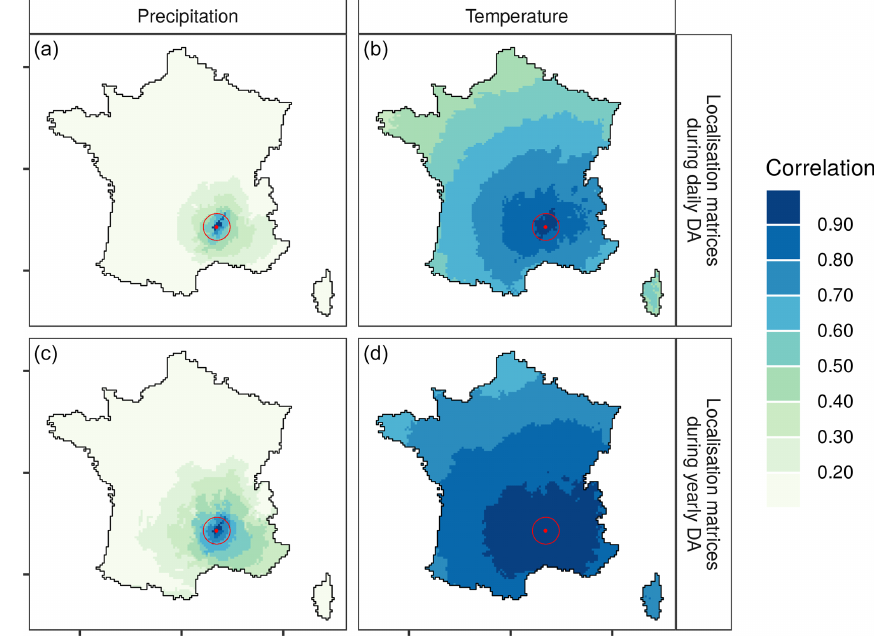
Figure 2. Correlation matrices between values from the case study cell (in red) and all other cells, for daily (a, b) and yearly (c, d) data assimilation, for precipitation (a, c) and temperature (b, d) .